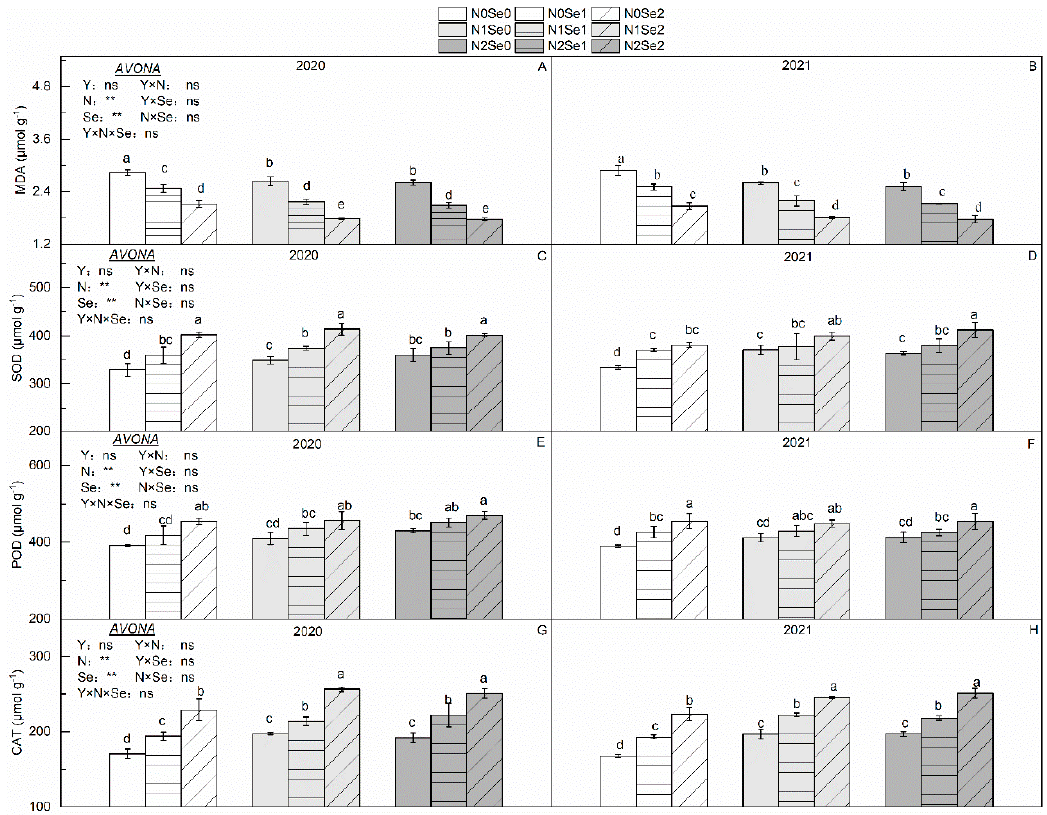
Figure 4. Effects of selenium and nitrogen fertilizers on oxidative stress in wheat. Y = Years, N = Nitrogen, Se = Selenium. ( A , C , E , G ) represent MDA, SOD, POD, CAT in 2020, respectively. ( B , D , F , H ) represent MDA, SOD, POD, CAT in 2021, respectively. N0, N1 and N2 indicate 0 kg N ha − 1 , 180 kg N ha − 1 and 270 kg N ha − 1 , Se0, Se1 and Se2 indicate 0 g Se ha − 1 , 450 g N ha − 1 and 900 g Se ha − 1 . Different lowercase letters indicate statistical differences among treatments at p < 0.05. “ns” means no significant difference ( p > 0.05). * and ** represent the significance levels of p < 0.05 and p < 0.01 respectively.